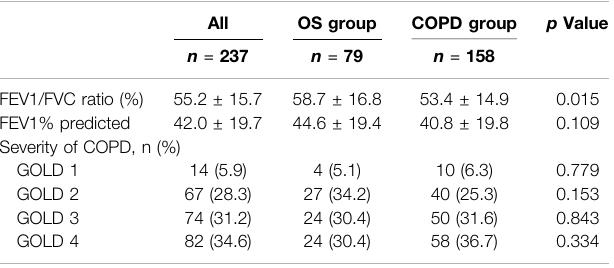
TABLE 2 | Pulmonary function tests and GOLD classi fi patients with OSAS than in those with OS (26.5 ± 16.6 vs. 25.1 ± 15.4; p (cid:1) 0.521), there was no obvious difference in the distribution of severity of OSAS in two groups. However,